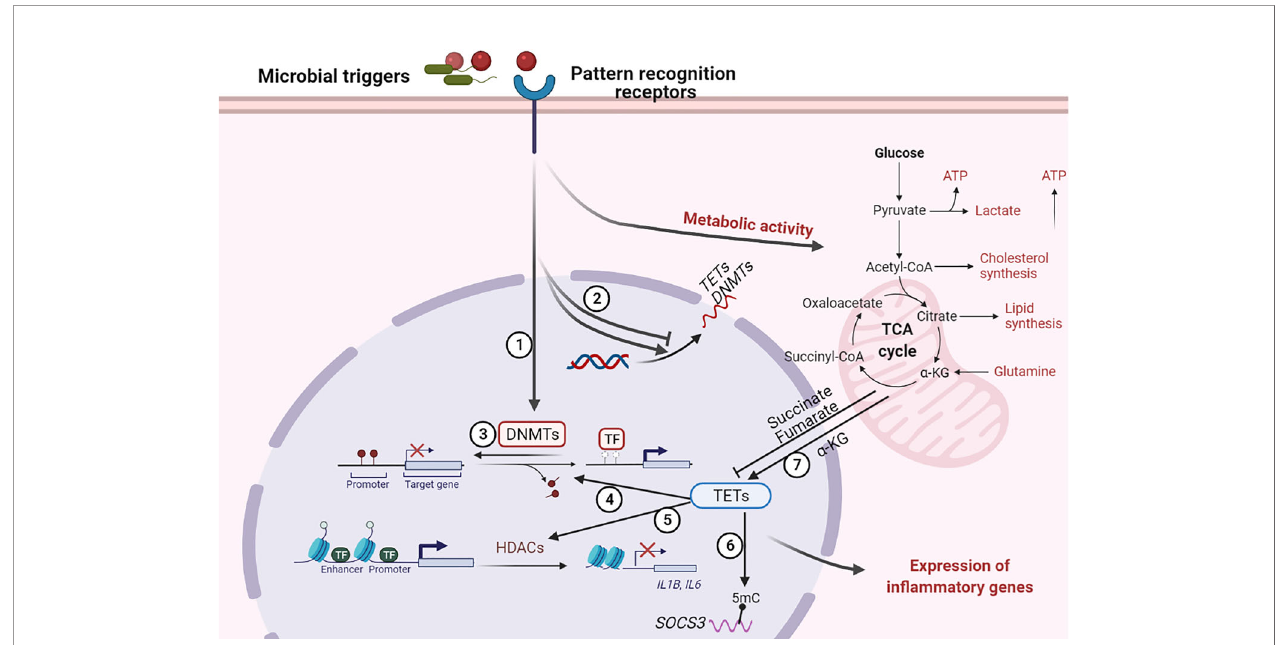
FIGURE 3 | Regulation of host DNA methylation of immune responses during infection. Figure representing a general overview of how infection can affect DNA methylation. Note: not all infection modify DNA methylation; an overview of changes induced by speci fi c pathogens is provided in the table. ① Infection induces DNA (de)methylation at target genes; ② Infection alters the transcription of DNA methylation modi fi ers TETs and DNMTs; ③ Loss of DNMTs promotes infection induced DNA demethylation at target genes; ④ TET proteins promote infection induced DNA demethylation at target genes; ⑤ TET proteins recruit HDACs for histone modi fi cation at IL1B and IL6 promoters; ⑥ TET proteins oxidize 5-methylcytosine (5-mC) on SOCS3 messenger RNA (mRNA); ⑦ Infection alter metabolic products that regulate the activity of TET proteins. “ arrow ” symbol represents promotion, “ bar-headed arrow ” symbol represents inhibition. DNMTs, DNA methyltransferases; TETs, ten-eleven translocation methylcytosine dioxygenases; HDACs, Histone deacetylases; TFs, transcription factors; IL, interleukin; SOCS3, Suppressor of cytokine signaling 3; ATP, Adenosine triphosphate; a -KG,